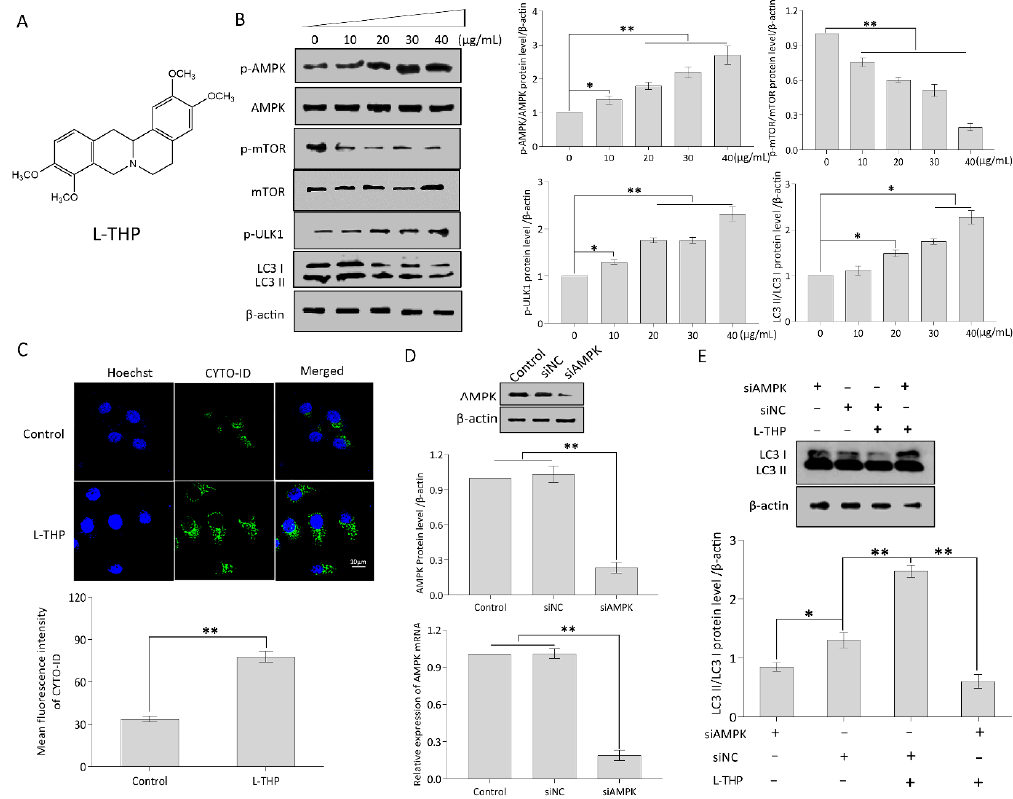
Figure 2. L-THP enhances autophagy through activating AMPK-mTOR-ULK1 cascade in HepG2 cells. ( A ) Chemical struc- ture of L-THP. ( B ) Western blotting were performed by using the respective antibodies against LC3, p-ULK1, p-AMPK, AMPK, p-mTOR, mTOR, and β -actin. ( C ) After pretreatment with L-THP, the cells were stained with CYTO-ID and Hoechst 33 , 342 and confocal microscopy images were taken. ( D ) Knock-down AMPK of siRNA was presented by western blotting or quantitative RT-PCR analyses. ( E ) LC3 II/I ratio was measured after AMPK knockdown with siRNA. Confocal images were quantified by using Image J software. Data are presented as mean ± SD. * p < 0.05 and ** p < 0.01, versus the control, are significant difference.